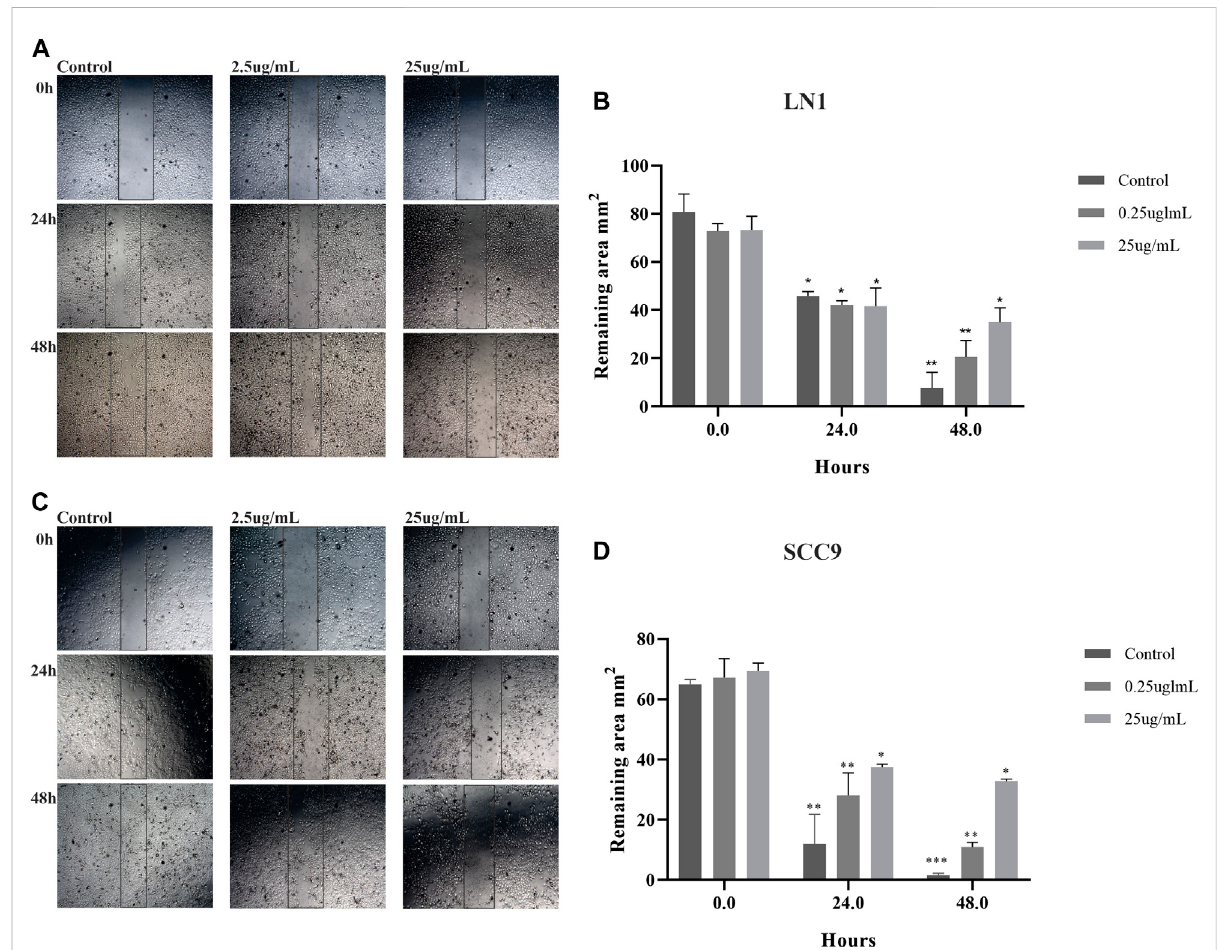
FIGURE 2 PLtreatmentdecreasesthemigrationofOSCCcelllines.Photomicrographsofcelllinesweretakenat0,24,and48 hafterwounding(40X).The average width of the lacunae was measured. Migration of SCC-9 cells treated with PL was signi fi cantly decreased, in comparison with non-treated cellsforboth24and48 hoftreatment (A) .LN1cellstreatedwithPLmigratedsigni fi cantlylessfor48 hincubation (B) .Migrationanalysisbasedonthe scratch wound assay showed that cells treated with PL closed the scratch wound signi fi cantly slower than the cells not treated (control). The graphscompile experimentaltriplicatequanti fi cationanalyses oftheremainingarea, andtheresultswereobtained byTwo-way ANOVAfollowedby Tukey assay, where * p < 0.05 , ** p < 0.01 , and *** p <